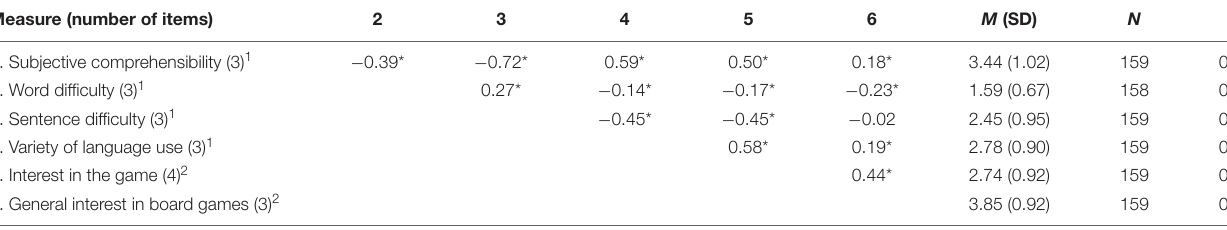
TABLE 1 | Psychometric properties and intercorrelations between the variables in Experiment 1. Measure (number of items)